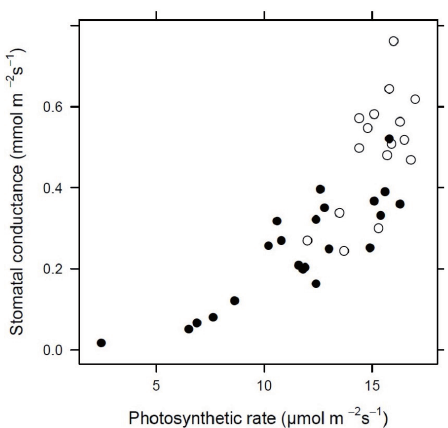
Fig. 7: Relationship between stomatal conductance and phyotosynthetic rate determined in leaves of S. hermaphrodita ( ○ ) and S. perfoliatum ( ● ). Measurements were performed under controlled conditions on three days during the establishment phase (see Materials & Meth-